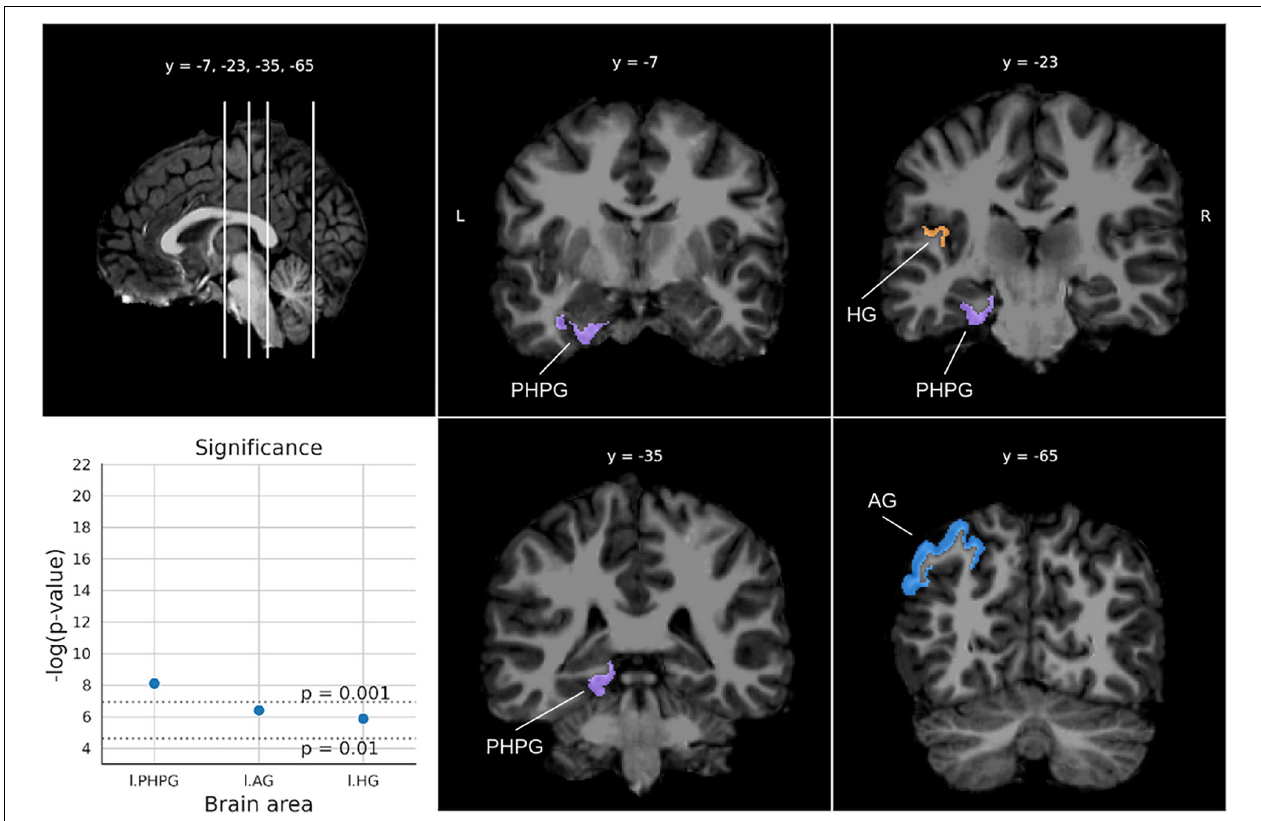
FIGURE 7 | Significant areas for the Quantitative concepts test with corresponding plots of the logarithmic p -values for each area. Coordinates are in MNI space. Brain areas: PHPG (Parahippocampal gyrus, parahippocampal part of the middle occipito-temporal gyrus), AG (Angular gyrus), HG [Anterior transverse temporal gyrus (of